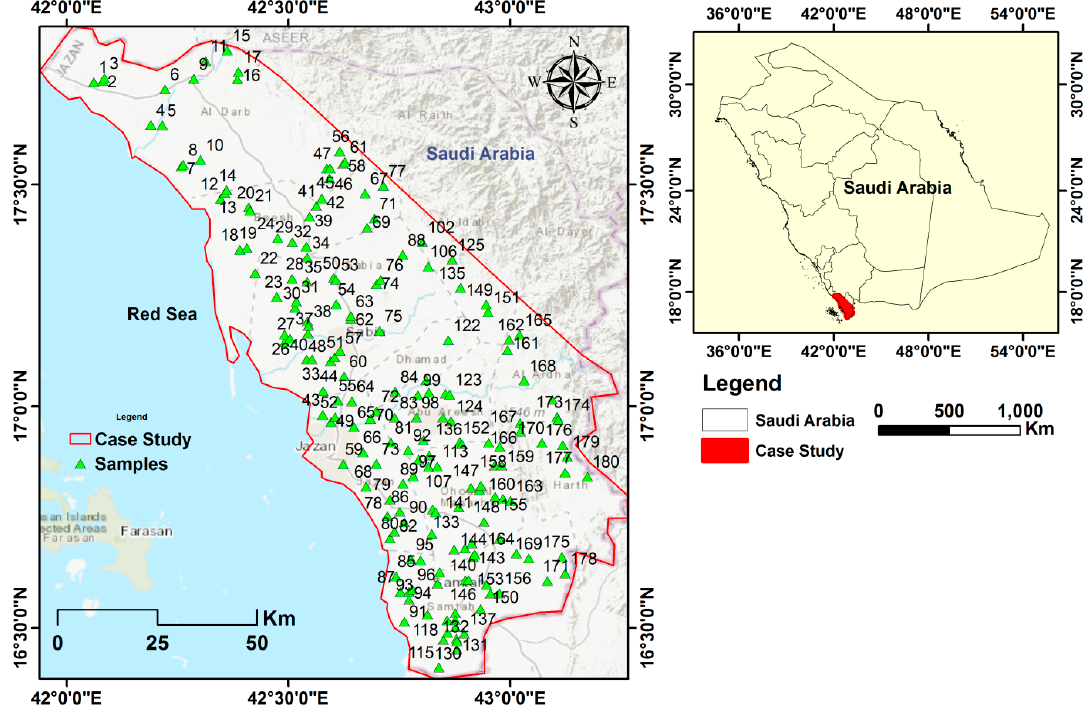
Figure 1. The study area and locations of samples.